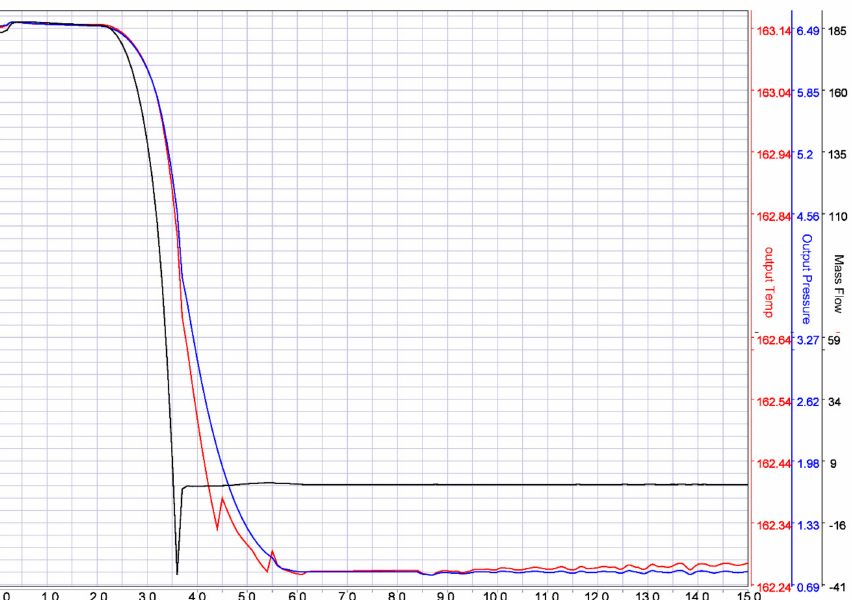
Figure 11. The mass flow, output pressure, and temperature of the second pump (2 MW) in Apros when a single-phase fault occurs in the electrical